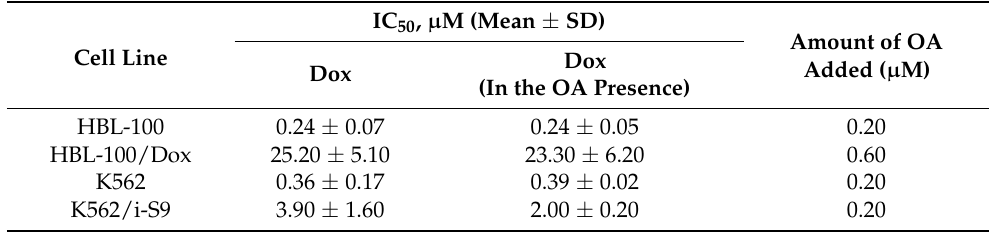
Table 2. Cytotoxicity of Dox and combination of Dox and OA toward HBL-100 and K562 cells and their resistant subclones. Subtoxic concentrations of OA were used (MTT test, 72 h).